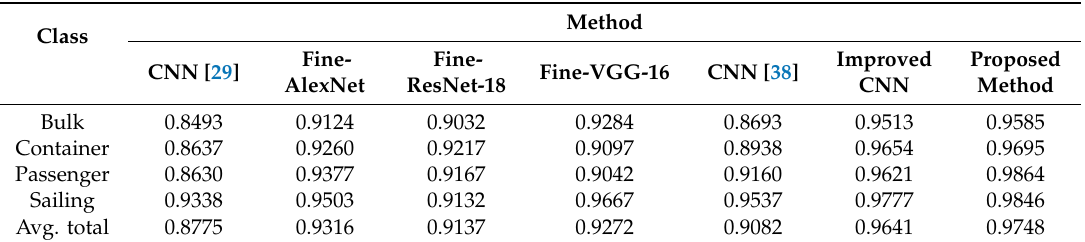
Table 11. F1-score obtained using di ff erent CNN methods when applied to the self-built dataset.